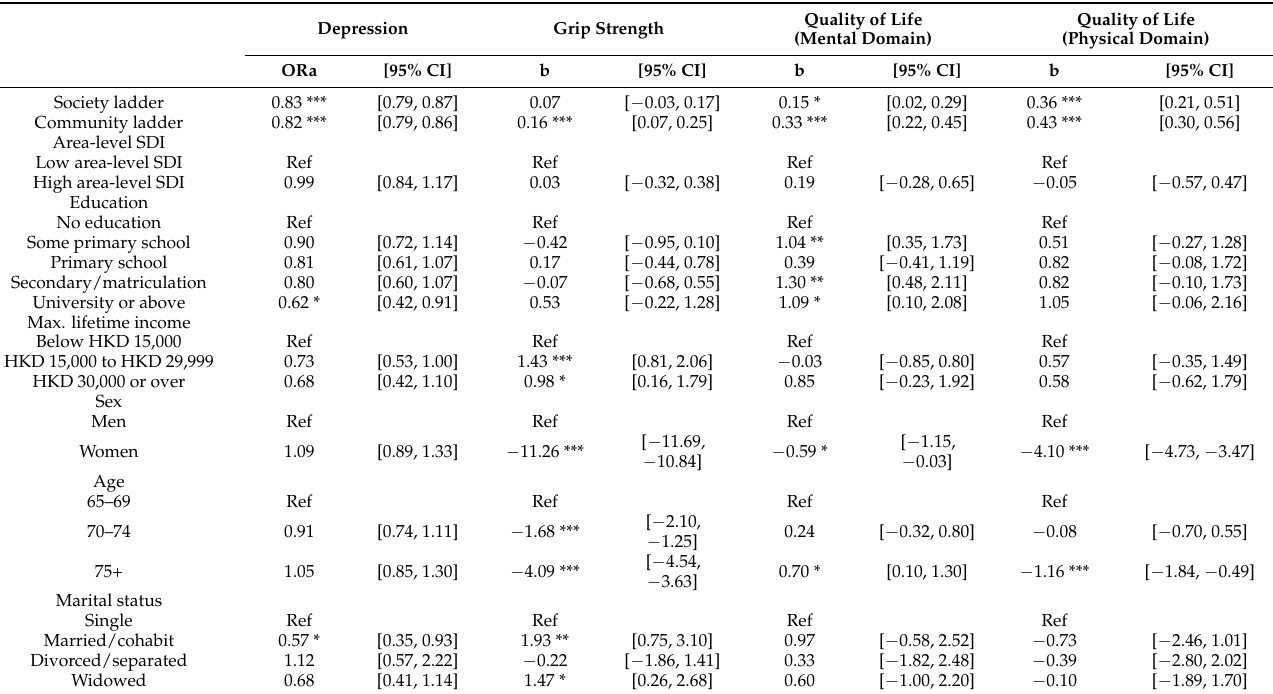
Table 2. Associations between subjective social status, area deprivation, and health outcomes. Depression